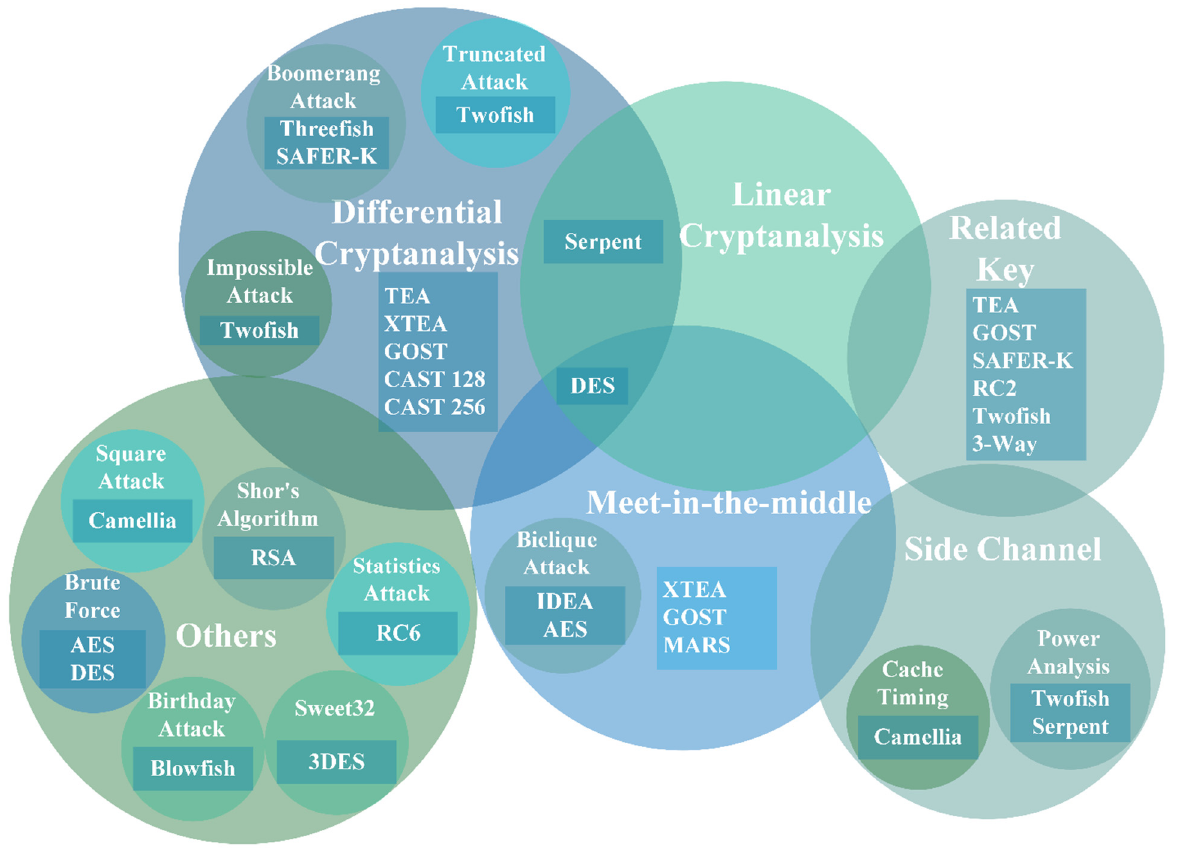
Figure 4. Graphic review of cryptographic cryptoanalysis.